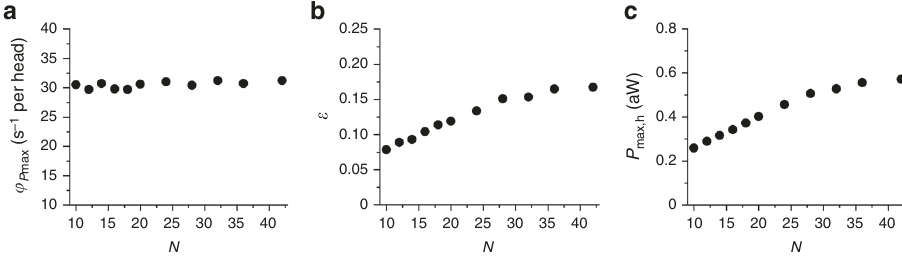
Fig. 5 Model predictions of the energetic parameters. Dependence on N of the various parameters is calculated at the maximum power ( P max ). a Rate of ATP hydrolysis per myosin head, φ P max . b Ef fi ciency, ε . c Power per myosin head, P